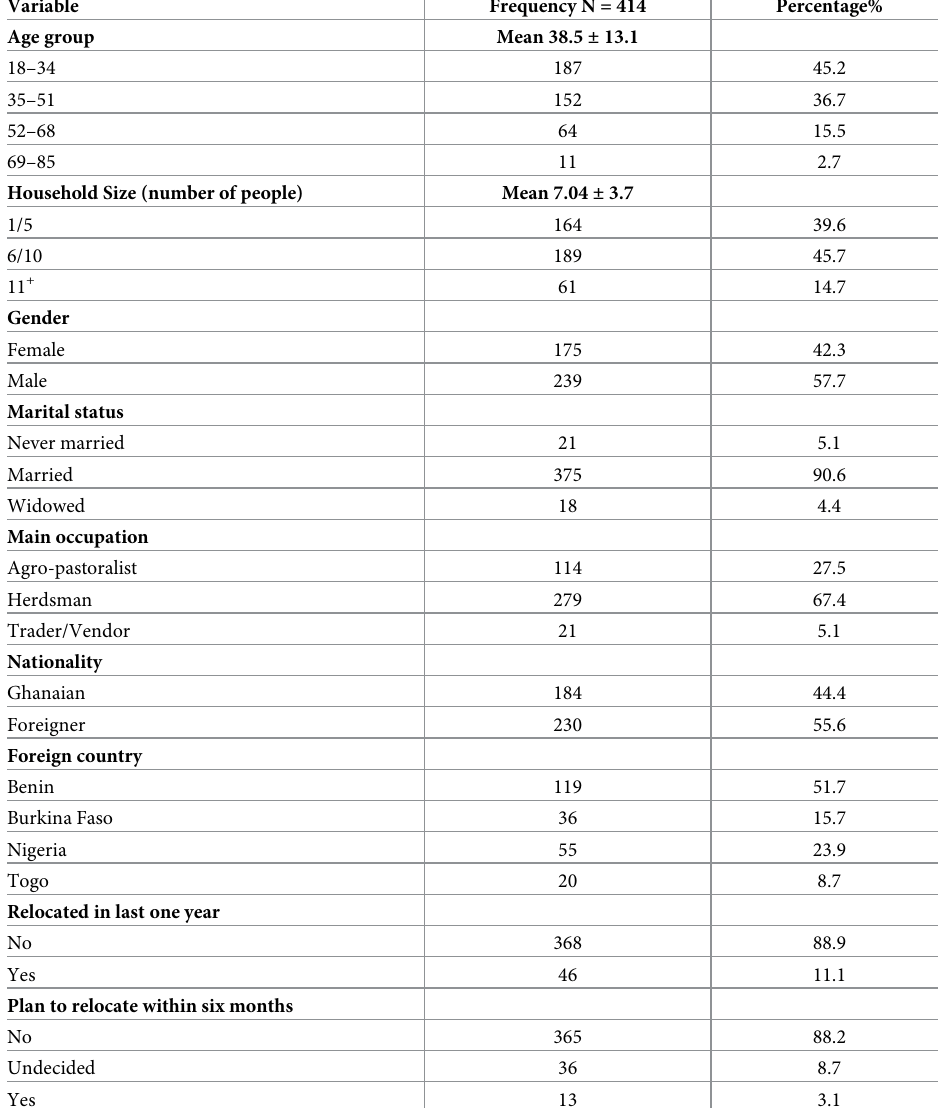
Table 1. Sociodemographic characteristics of nomadic in the West Gonja Municipal Ghana, 2022.